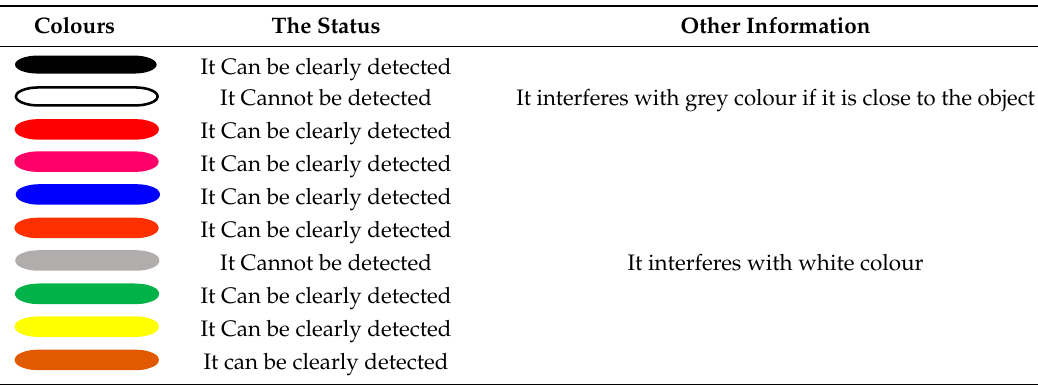
Figure 3. Different coloured objects.